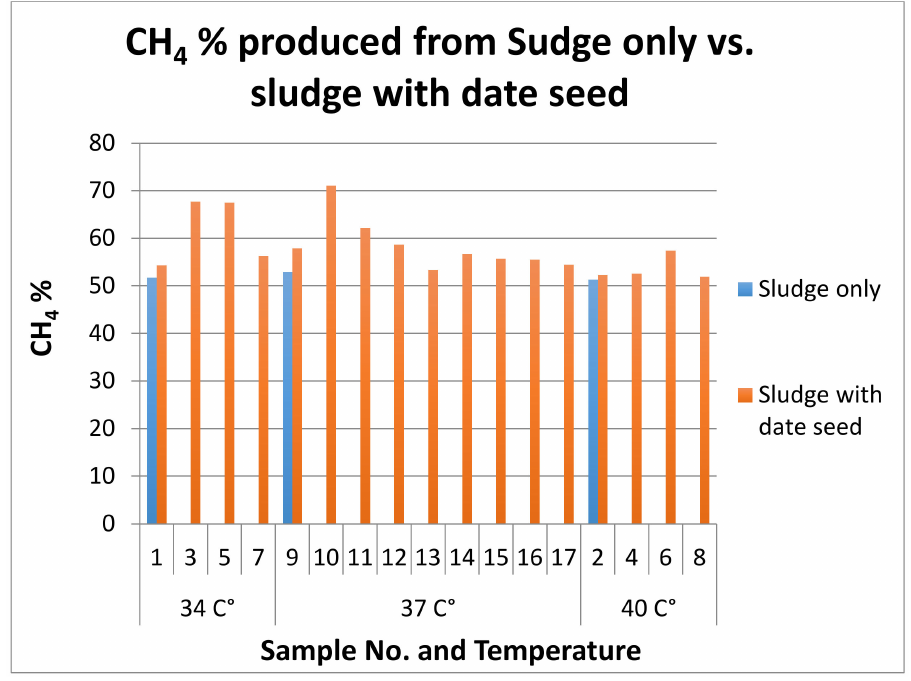
Figure 4. CH 4 % variance when adding date seed to the sludge.